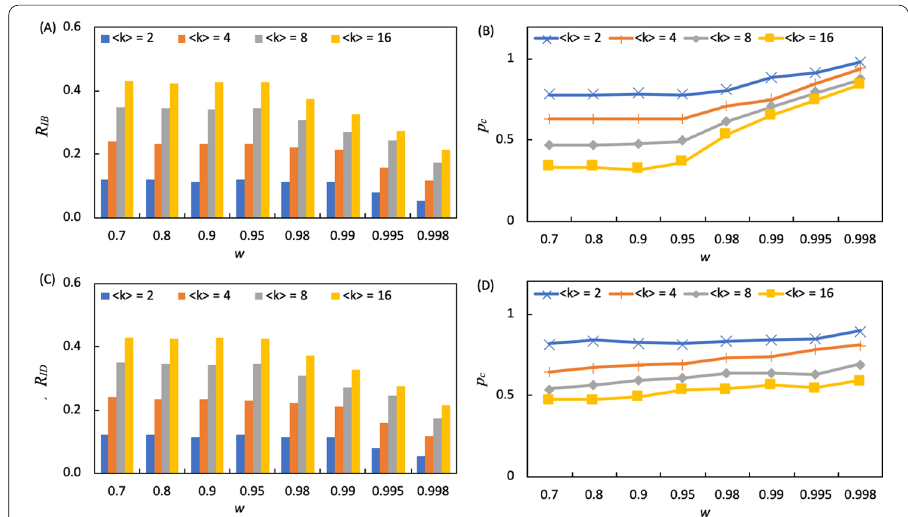
Fig. 7 Robustness measures of simulation result for the modular networks generated from BA network with N 10,000, m 5 with different value of rewiring probability w and for different node average degree (cid:31) k (cid:30) : = = A , C the single value network robustness ( R ) and B , D the critical occupation probability p c as a function of the re‑wiring ratio w for different node average degree (cid:31) k (cid:30) for IB and ID strategies, respectively. All results are averaged over 100